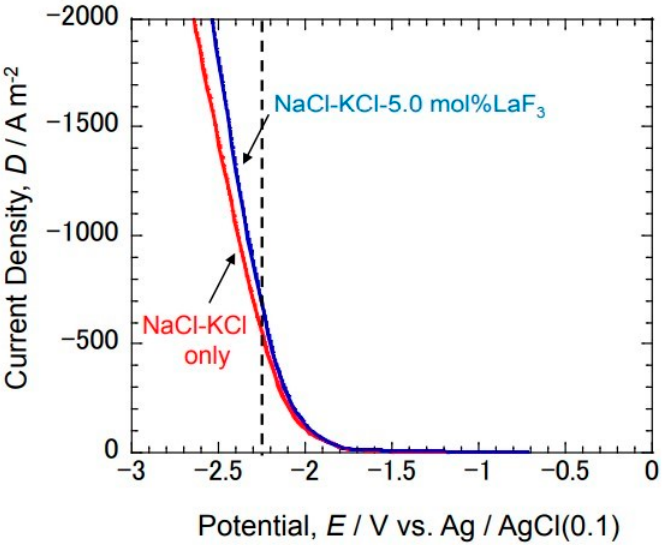
Figure 3. Cathode polarization curves of Ni in NaCl-KCl-5.0 mol%LaF 3 melts at 750 °C.